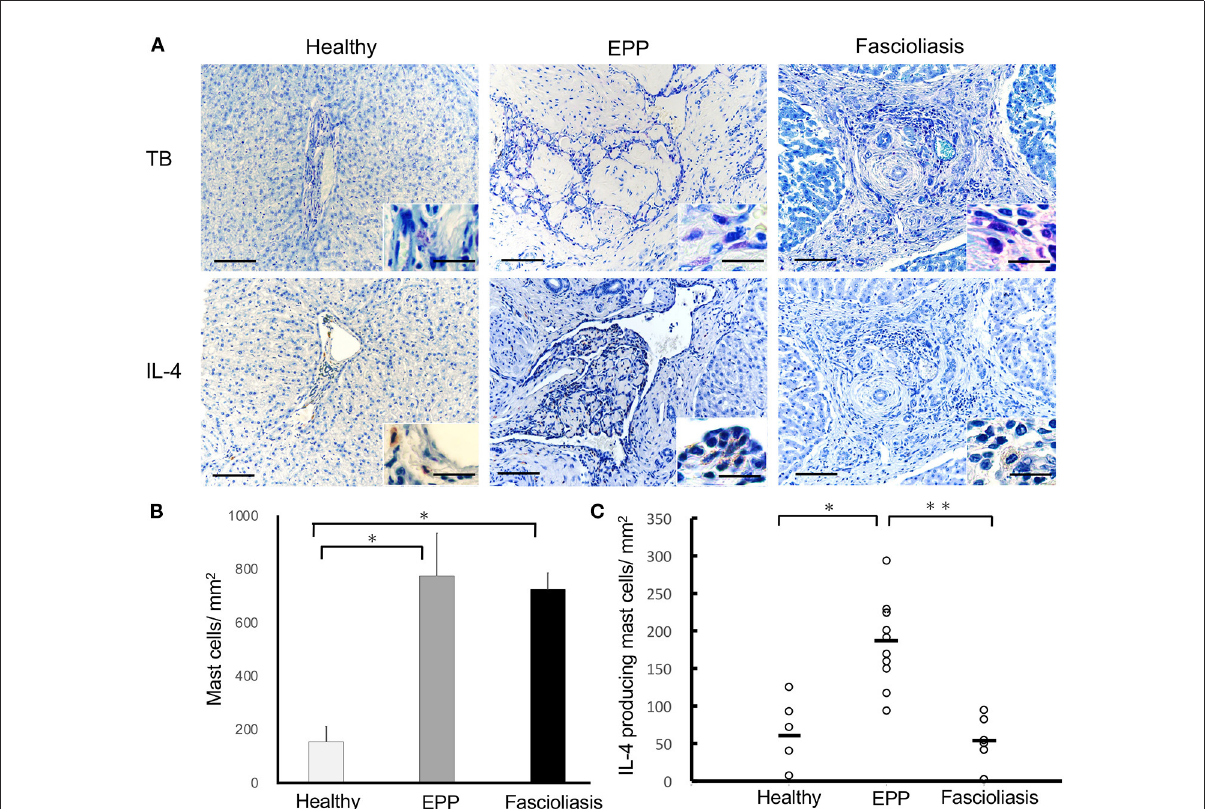
FIGURE2 Mast cell infiltration and IL-4 production in bovine liver. (A) Hepatic interlobular triad region of a healthy liver (Healthy), an eosinophilic proliferative phlebitis (EPP) case, and a chronic fascioliasis case (Fascioliasis) were indicated using toluidine blue staining or immunostaining by anti-IL-4 Abs (IL-4) in hematoxylin stain background. Inset is a high-magnification image. Each scale bar indicates 50 µ m in low-magnification images and 10 µ m in high-magnification images. (B) Average numbers of mast cells per 1 mm 2 were indicated in the healthy cattle ( n = 5), EPP cattle ( n = 10), and fascioliasis cattle ( n = 6). * P < 0.02, analysis of variance (ANOVA). (C) Numbers of IL-4–positive mast cells per 1 mm 2 were indicated in the healthy cattle ( n = 5), EPP cattle ( n = 10), and fascioliasis cattle ( n = 6). Black bars, mean value of each cattle. * P < 0.05, ANOVA; ** P < 0.04, ANOVA. IL-4,